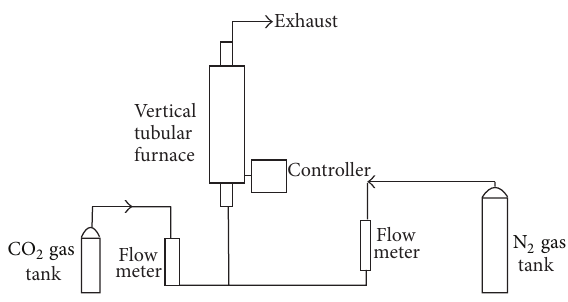
Figure 1: Schematic diagram of the experimental